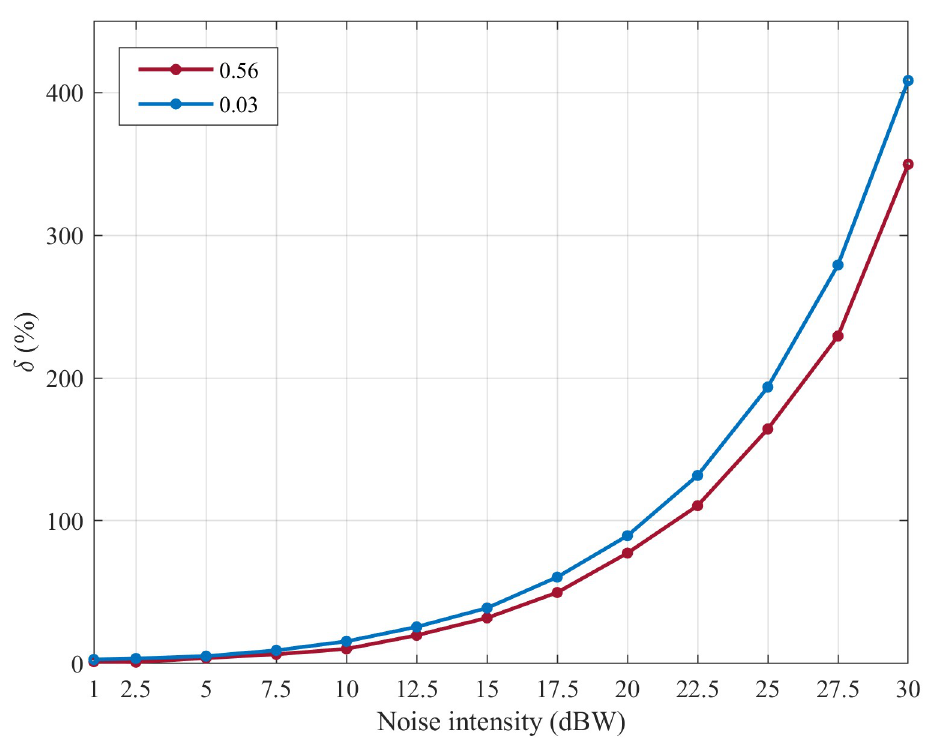
Fig 12. The change of the δ of a SFSNN with the high ACC and a SFSNN with the low ACC.